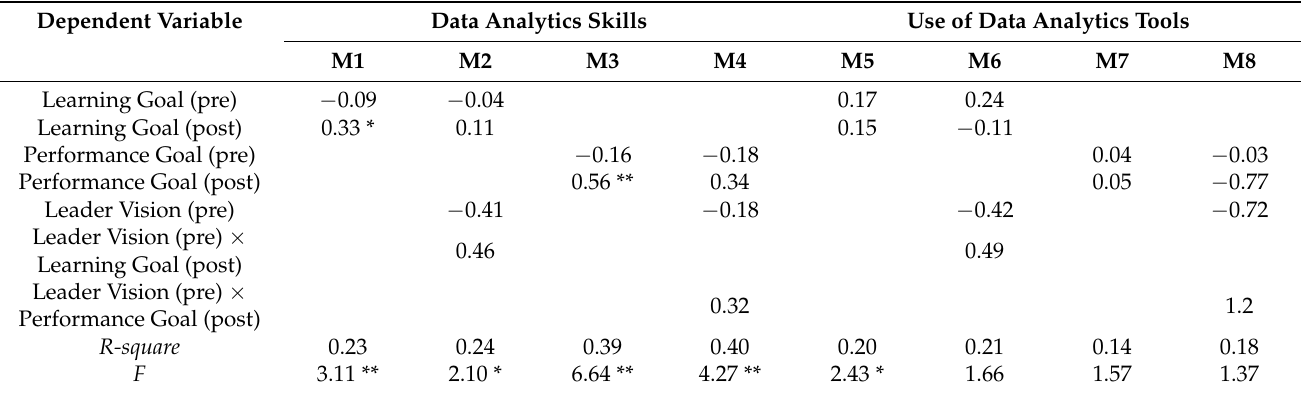
Table 3. Results of multiple regression